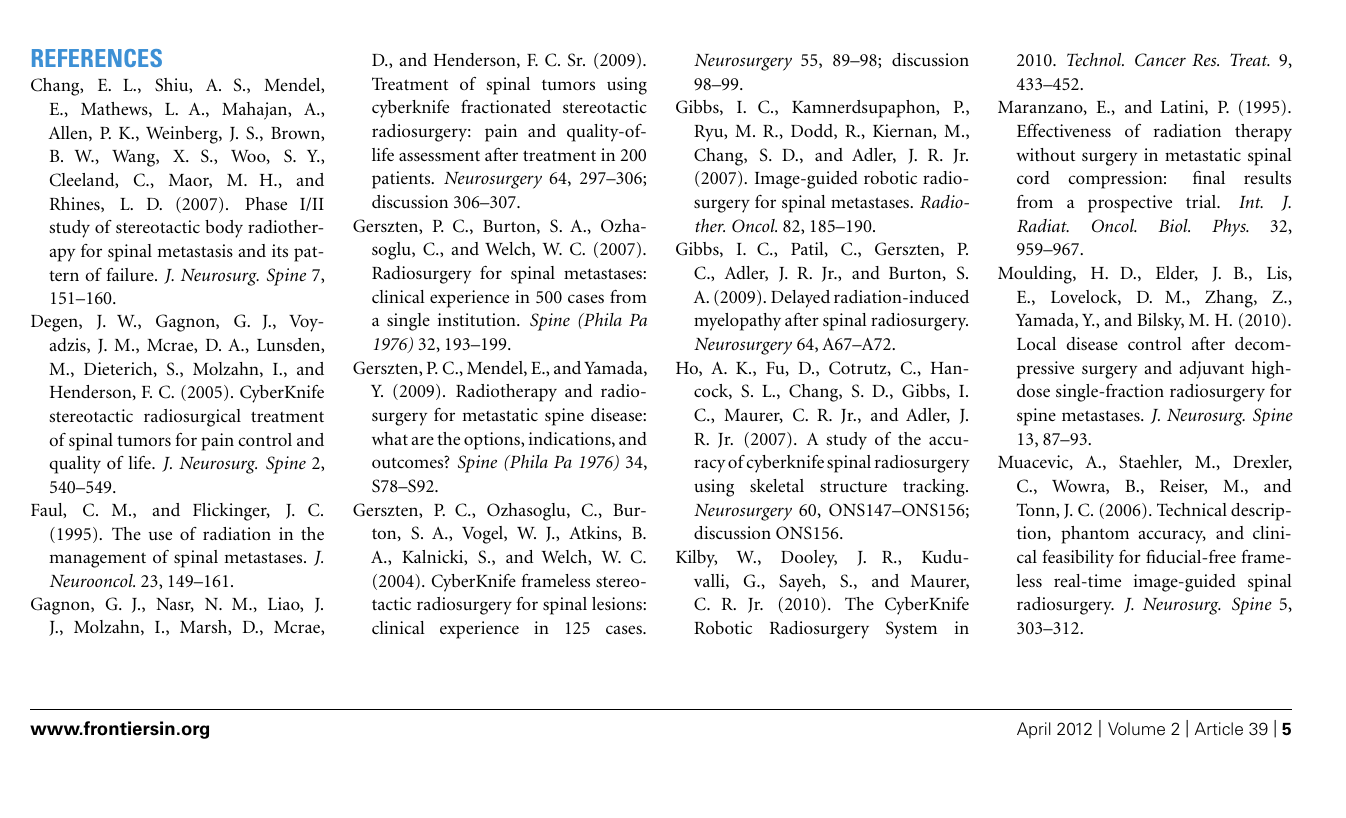
in order to address microscopic disease spread within theVB